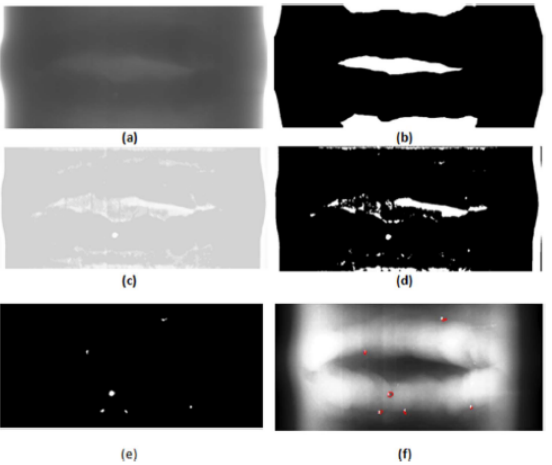
Figure 47. The image processing techniques applied to an original radiographic image of a weld prior to defect identification. ( a ) Clipping of the original image. ( b ) Thresholded image showing the region of interest. ( c ) Histogram equalisation. ( d ) Result of the combination of the image in ( b ) and the result of the Otsu thresholding of the image in ( c , e ); the revelation of potential defects and the region of interest and defects within 10% from the left/right and 7% top/bottom are discarded. ( f ) The labelling of defects after their edges are revealed by the morphological gradient method. Reprinted from NDT & E International, Volume 86, Boaretto, N.; Centeno, T.M. Automated Detection of Welding Defects in Pipelines from Radiographic Images DWDI, Page 7–13, Year 2017 with permission from Elsevier